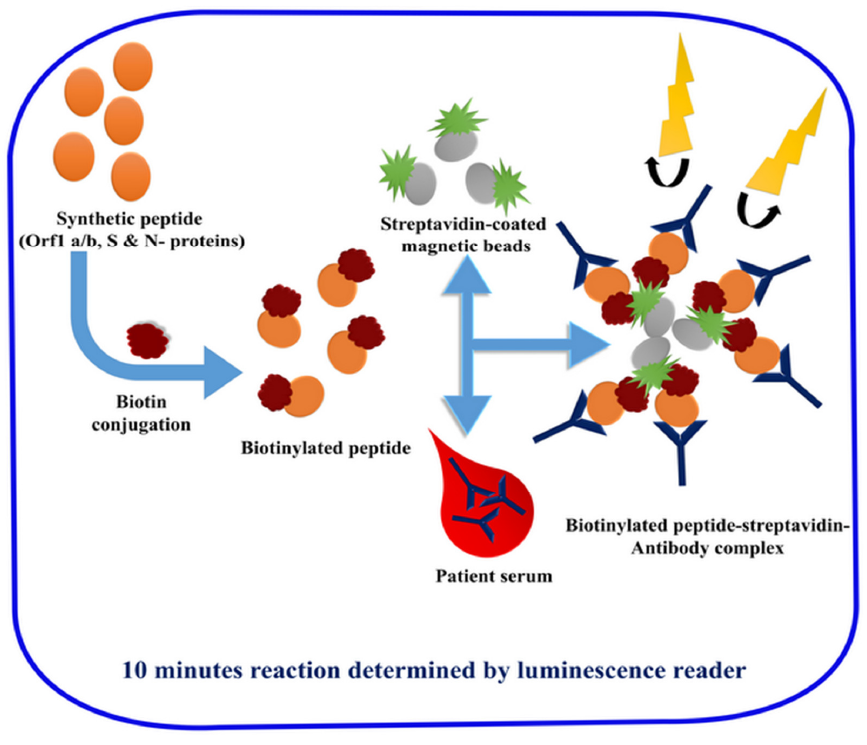
Figure 7. Peptide‐dependent magnetic chemiluminescence enzyme immunoassay. Figure 7. Peptide-dependent magnetic chemiluminescence enzyme